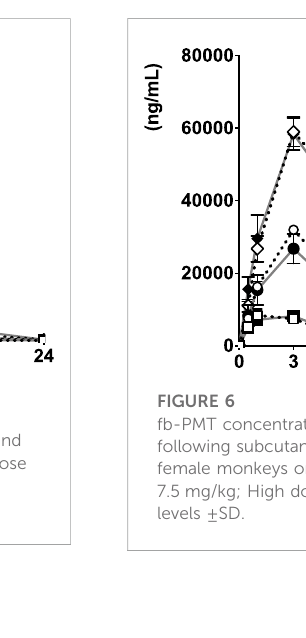
TABLE 3 Pharmacokinetic (Day 1) and Toxicokinetic (Day 28) parameters of fb-PMT Following Single and Multiple SC Doses of fb-PMT in Female and Male Cynomolgus